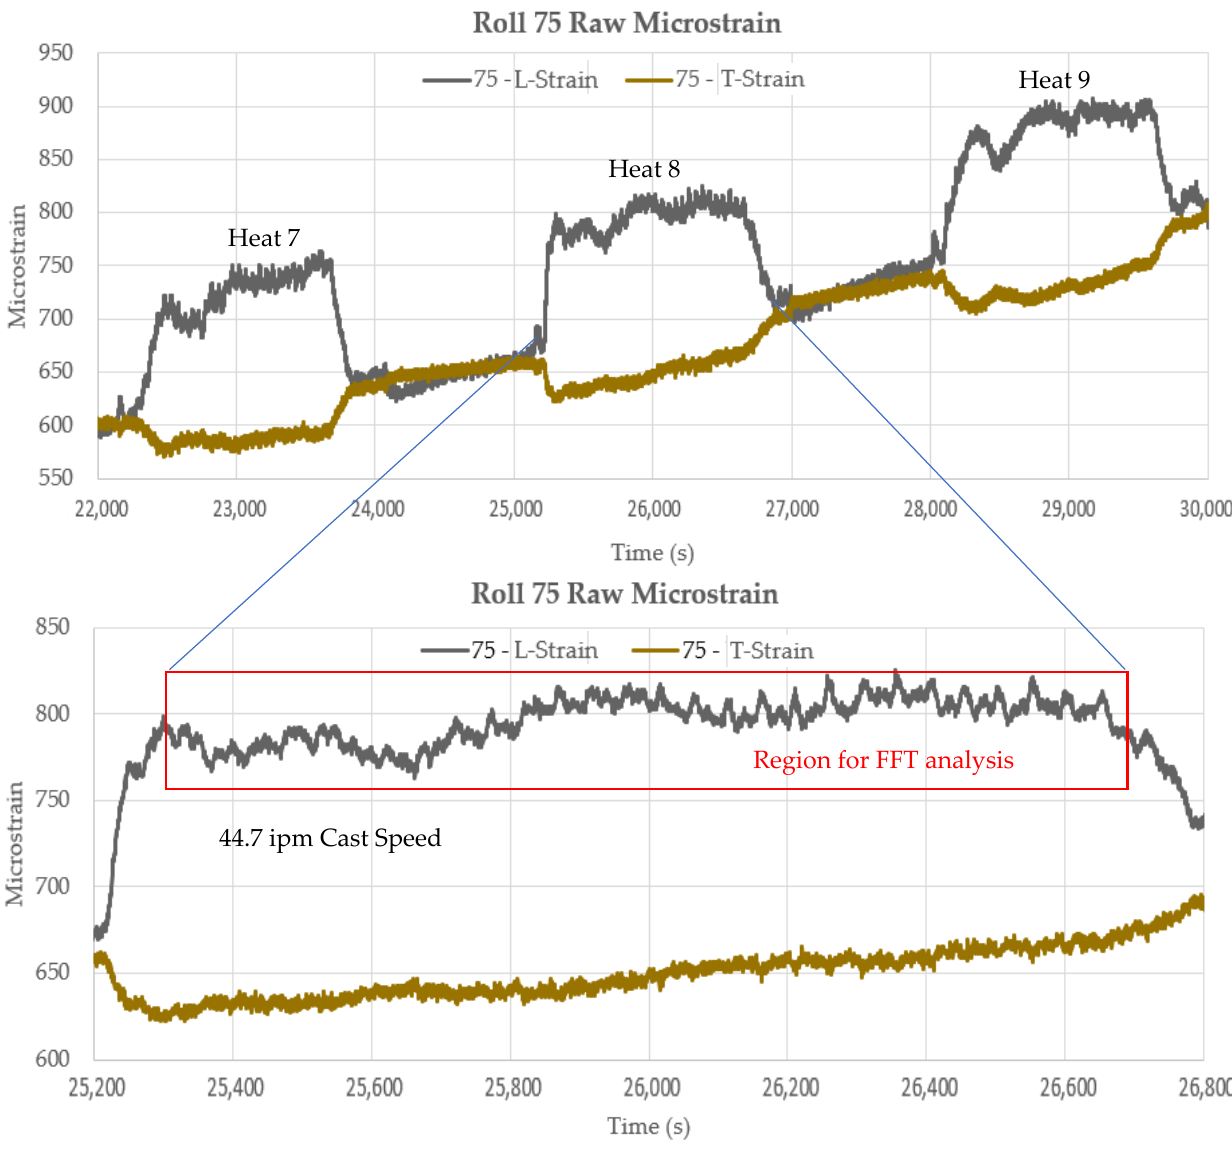
Figure 23. Typical raw strain signal fluctuations in presence of liquid core loading.